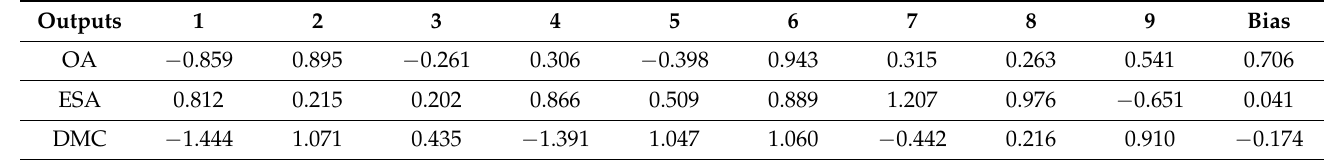
Table 6. The weight coefficients and biases W 2 and B 2